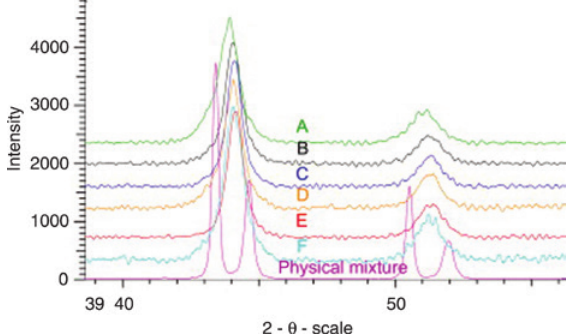
Ni samples with various composi- Figure 4: XRD patterns of Cu 1− x x tions (A: x = 60, B: x = 70, C: x = 72.5, D: x = 73, E: x = 75, and F: x = 80) and the optimum milling time of 20 h. The patterns are compared with the pattern of physical mixture. Reproduced with permission from Elsevier: Journal of Magnetism and Magnetic Materials [22].